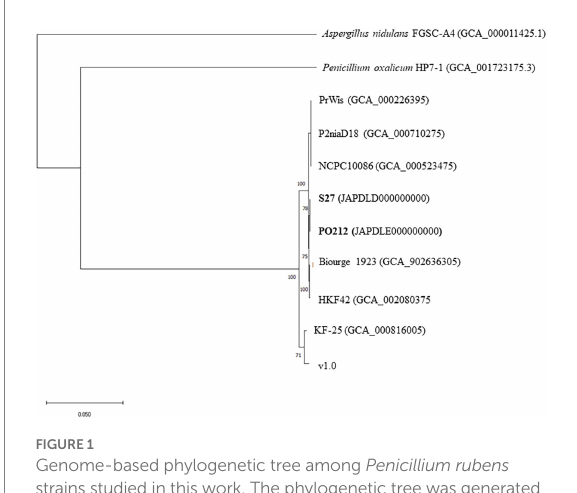
FIGURE 1 Genome-based phylogenetic tree among Penicillium rubens strains studied in this work. The phylogenetic tree was generated using the software JolyTree. The Aspergillus nidulans strain FGSC-A4 genome and Penicillium oxalicum strain HP7-1 genome were used as outgroups.